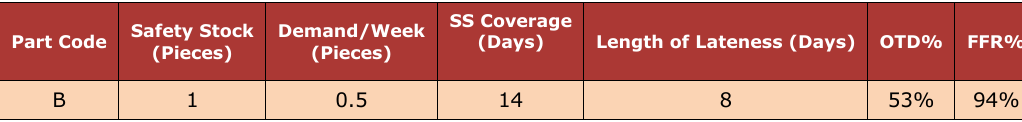
Table 9. Safety stock simulation model-sample